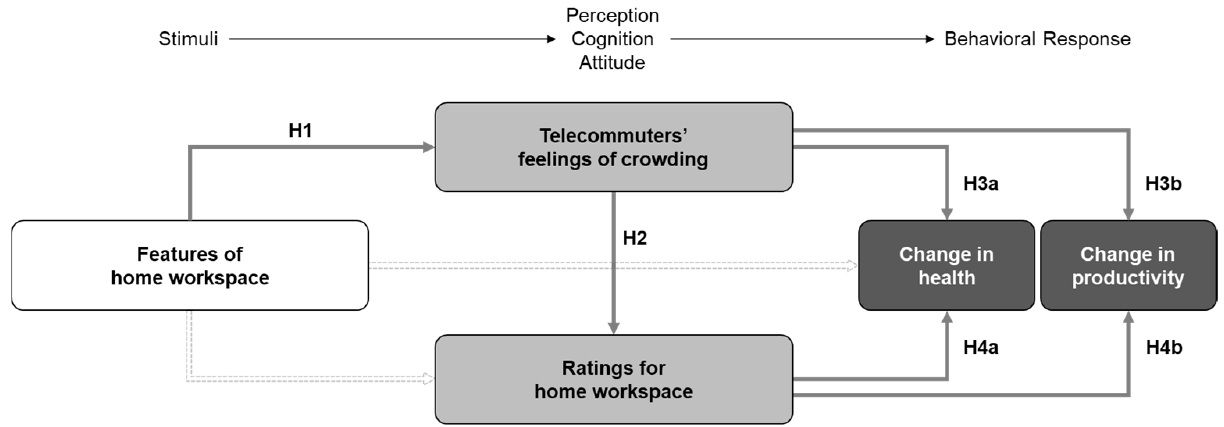
Figure 1. Overview of conceptual model and hypotheses.